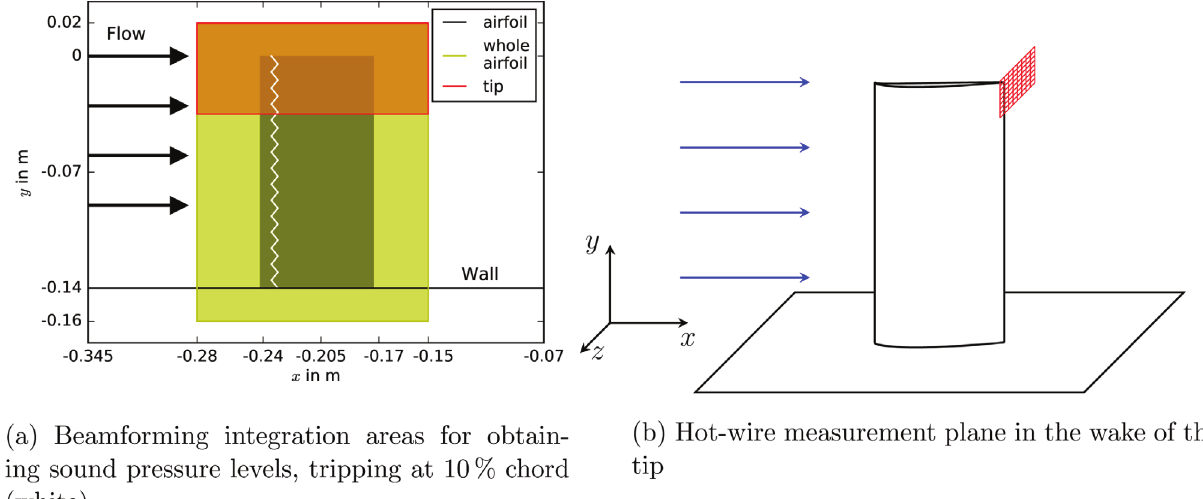
Figure 3. Measurement evaluation